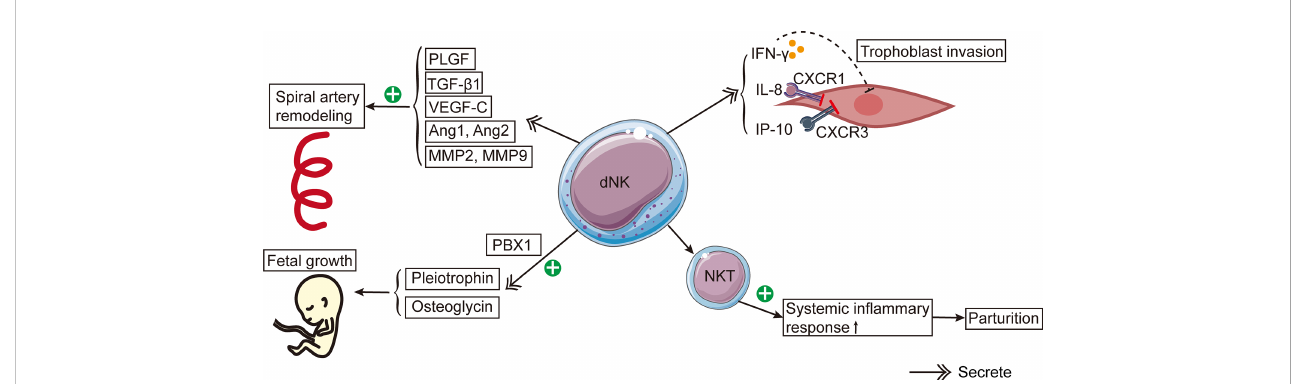
FIGURE 1 The schema of roles of dNK cells in reproduction. dNK cells contribute to the spiral artery remodeling by producing PlGF, TGF- b 1, VEGF-C, Ang1, Ang2, MMP-2, and MMP-9. Besides, dNK cells secrete IFN- g , IL-8, and IP-10, which inhibit trophoblast invasion. CXCR1 and CXCR3 are the corresponding receptors of IL-8 and IP-10, respectively. dNK cells stimulate fetal development by secreting pleiotrophin and osteoglycin. PBX1 raises the mRNA expression levels of pleiotrophin and osteoglycin. The activation of NKT cells induces a systemic in fl ammatory response, leading to the onset of